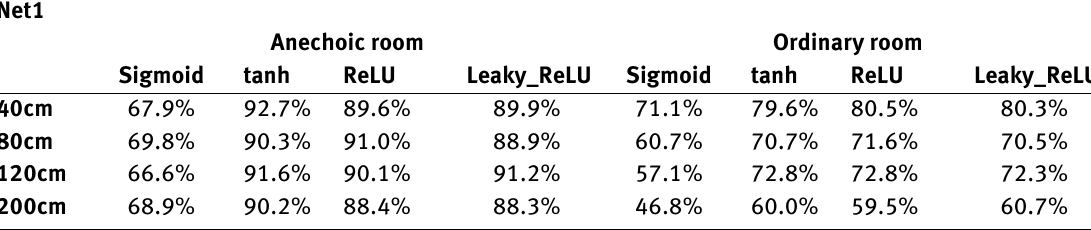
Table 3: Experimental results based on